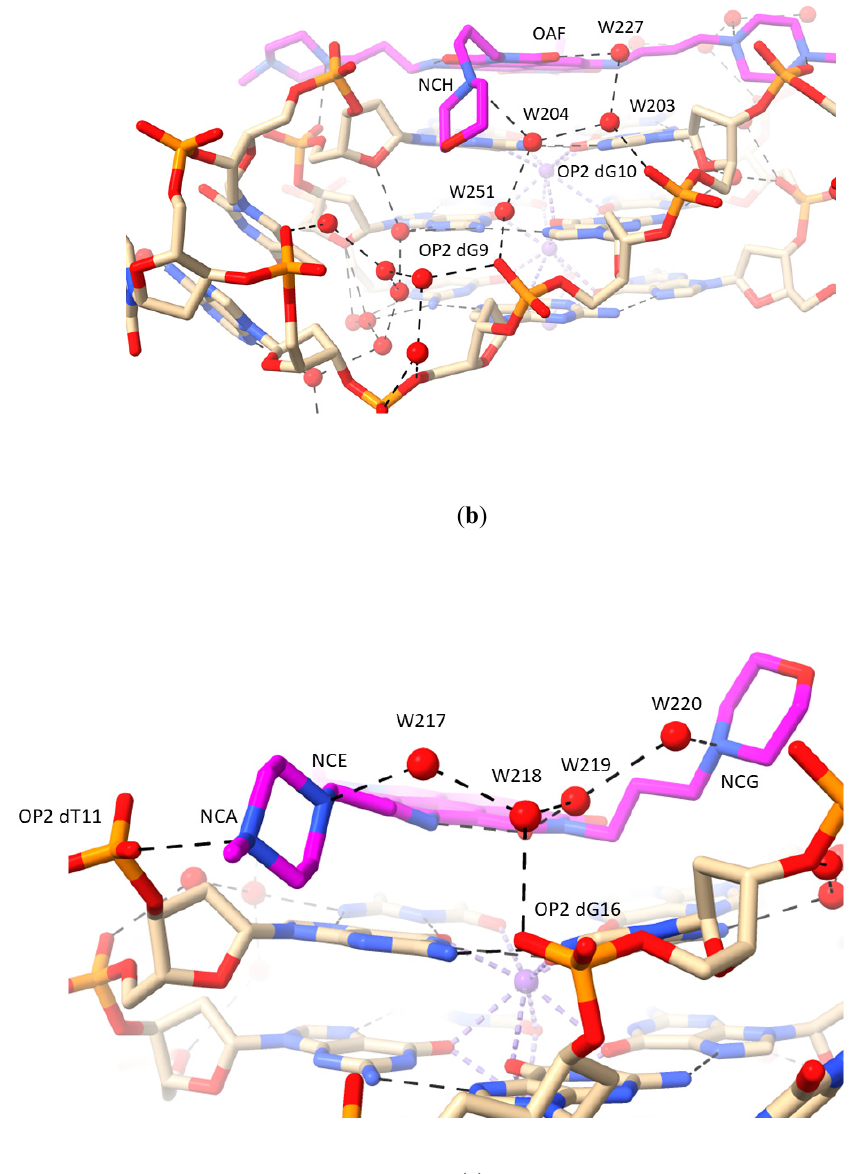
Figure 2. Views of the crystal structure of MM41 (with its carbon atoms colored magenta) bound to a human intramolecular telomeric G-quadruplex, PDB id 3UYH. ( a ) The view is projected onto the G-quartet plane and shows the extent of overlap with the naphthalene diimide core chromophore. The water molecules that are in direct or indirect contact with the MM41 molecule, are shown as red spheres, with hydrogen bonds indicated by dashed lines. This and the subsequent figures were drawn using the ChimeraX package (https://www.cgl.ucsf.edu/chimerax/, last accessed on 16 December 2021) [125]. ( b ) A view of the 3UYH complex looking into groove 1. The four water mole- cules are shown that are hydrogen bonded to the morpholino group in this groove and the OAF carbonyl oxygen atom of the naphthalene diimide core. A nearby cluster of water molecules is also shown, embedded deep in the groove and adjacent to a TTA loop. ( c ) A view of the 3UYH complex midway between grooves 2 and 3, highlighting the group of four water molecules hydrogen bond- ing to an N-methyl-piperazine and a morpholino group in these grooves. All four basic end groups of MM41 have their protonated nitrogen atoms in hydro- gen bond/electrostatic contact with atoms in the GQ grooves (Table 2). However, only two